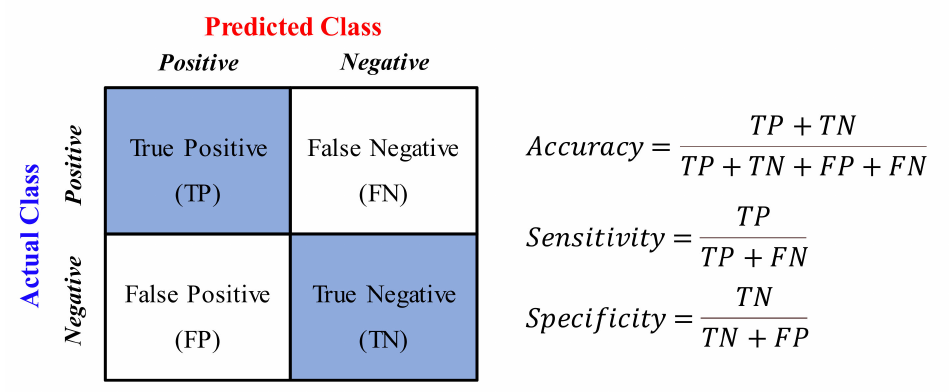
Figure 12. Concept of confusion matrix and definition of measuring indicators.